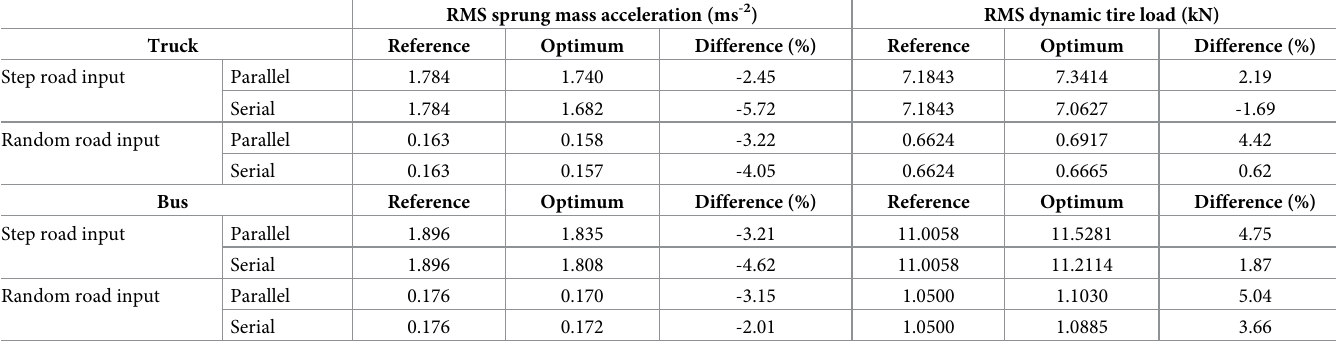
Table 4. Summary and comparison of heavy vehicle suspension performance considering optimization of damping and